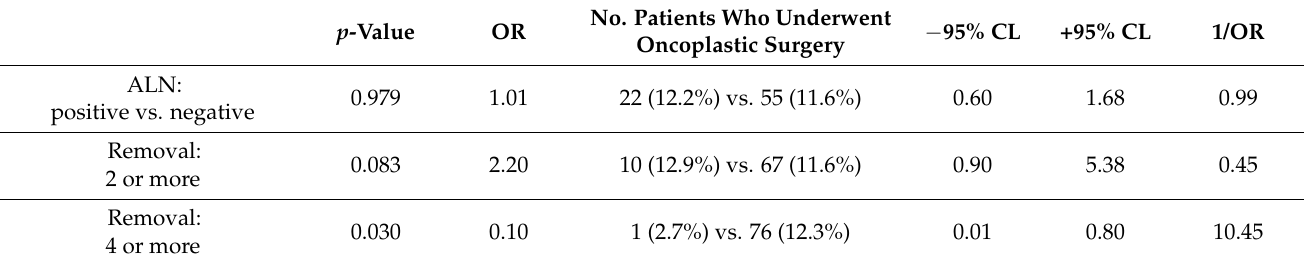
Table 7. The multivariate regression analysis on the performed oncoplastic surgery and the number of the metastatic lymph nodes